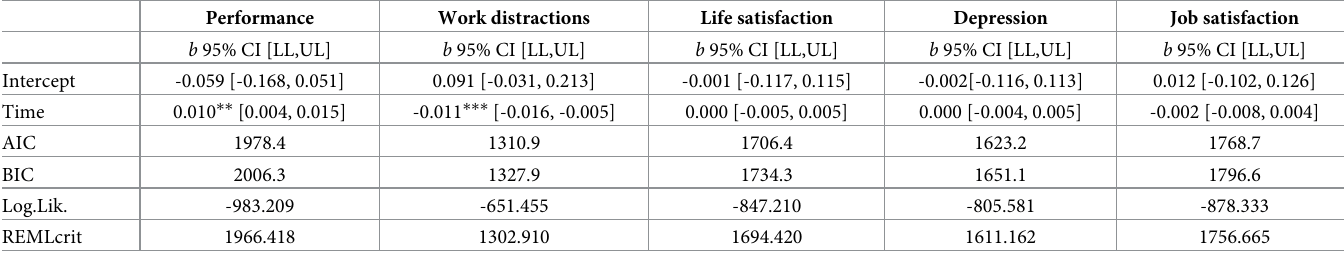
Table 3. Effect of time on worker